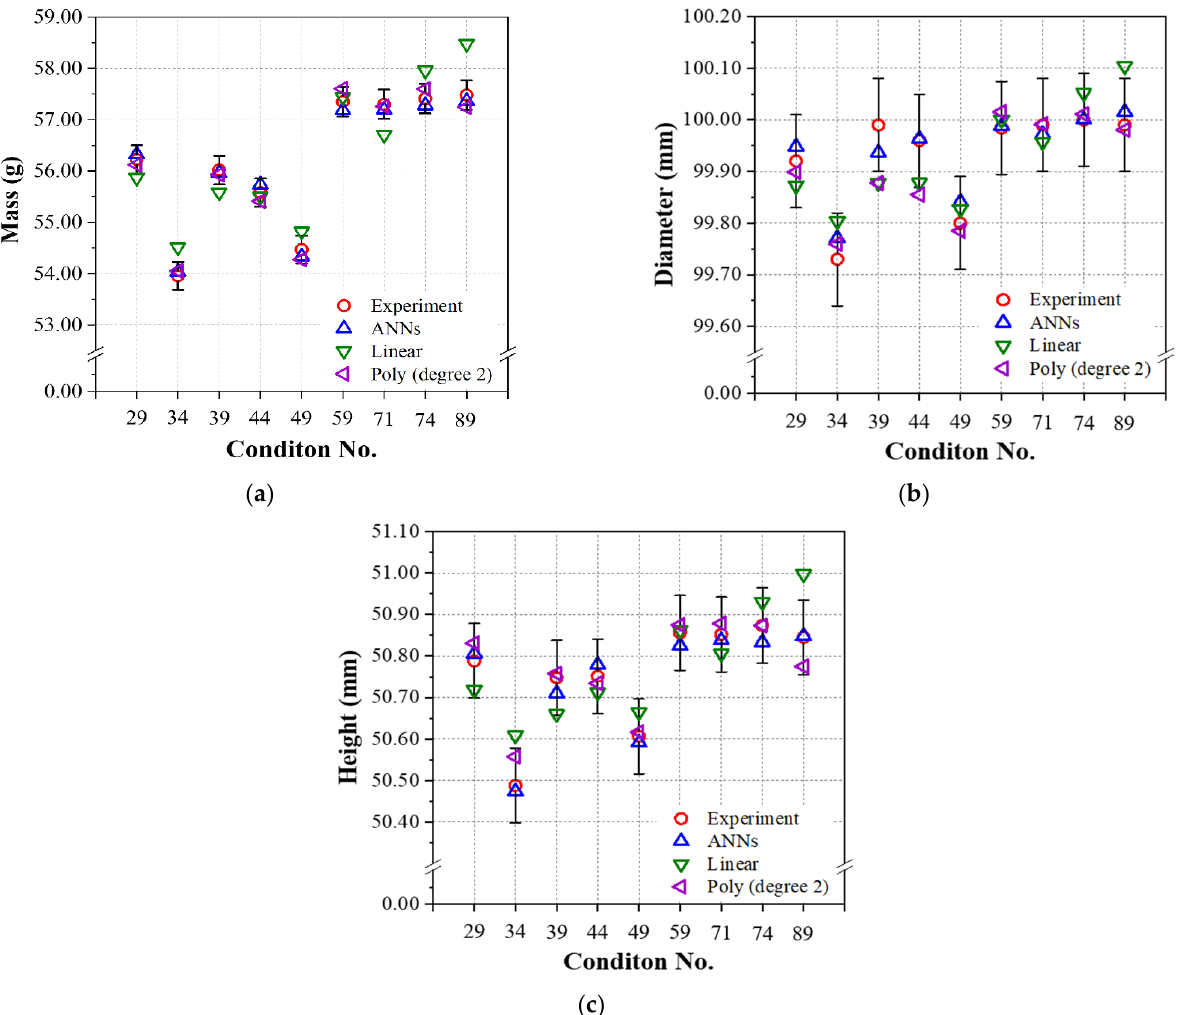
Figure 11. Performances of the prediction models using test data learned by the nonlinear relation group (packing time was 3.0–39.0 s): ( a ) mass, ( b ) diameter, and ( c ) height.